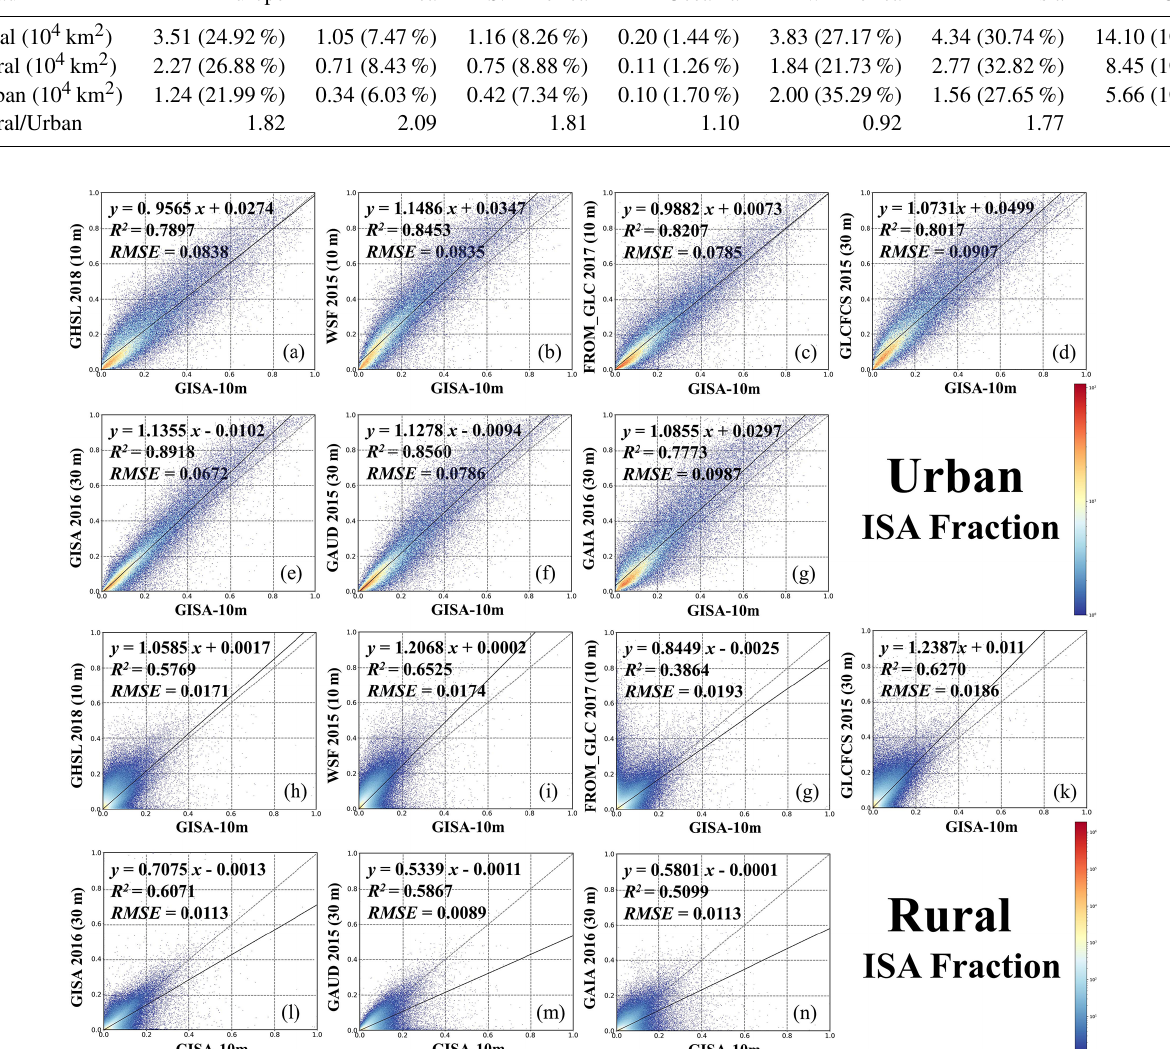
(0.5099 < R 2 < 0.6525). The fitted slopes between the